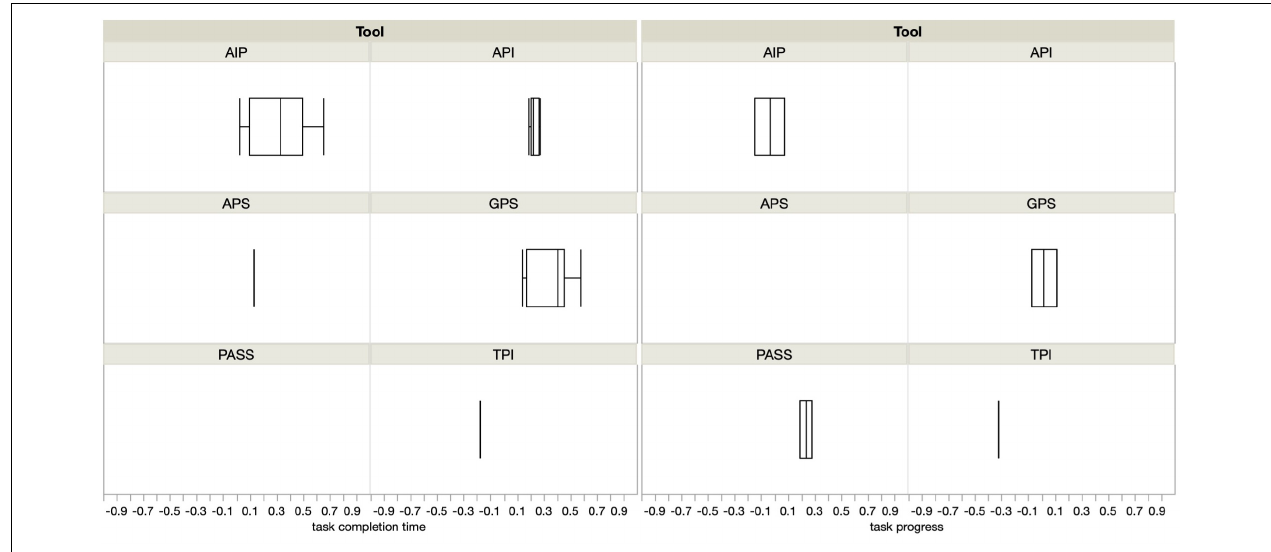
FIGURE 1 | Distributions of correlation coefficients depict the strength of the relationship between task completion time (left), task progress (right), and self-report measures of